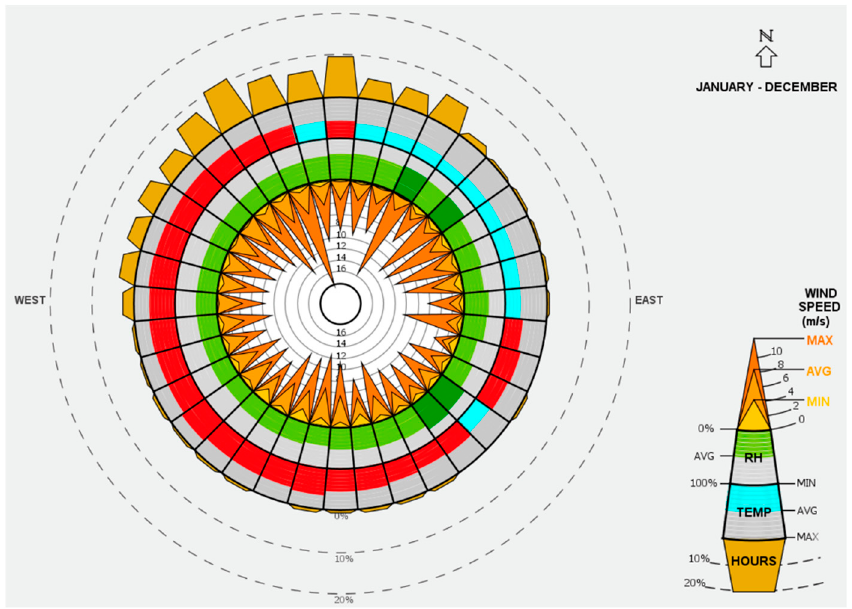
Figure 5. Average wind speed and wind direction in Jeddah, KSA [60].